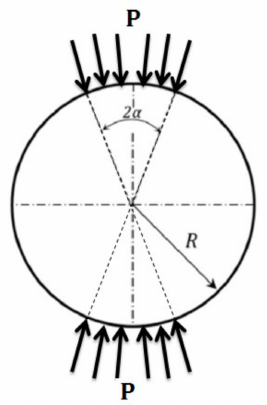
Figure 1. The Brazilian test configuration (loading arch).